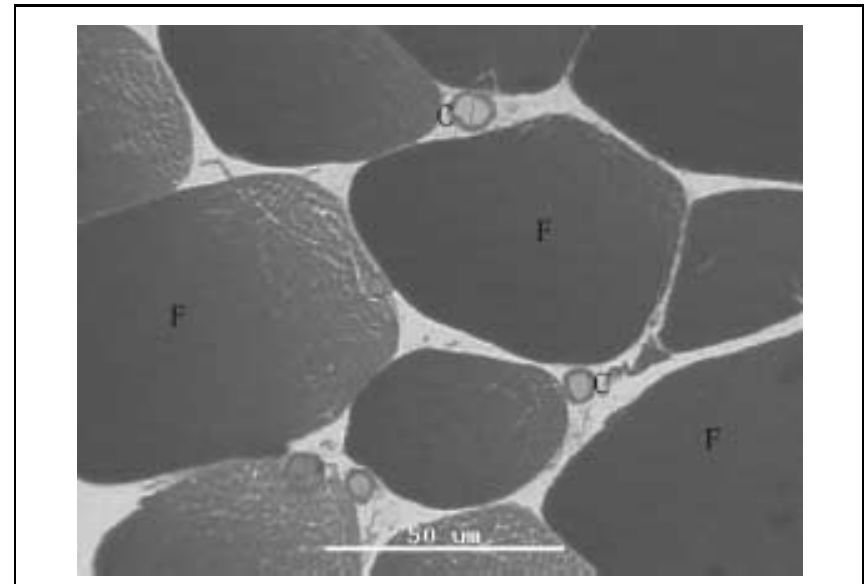
Figure 1: Light micrograph showing cross-sectioned capillaries and measurement positions, 40X magnification. (F = myofibre, C =